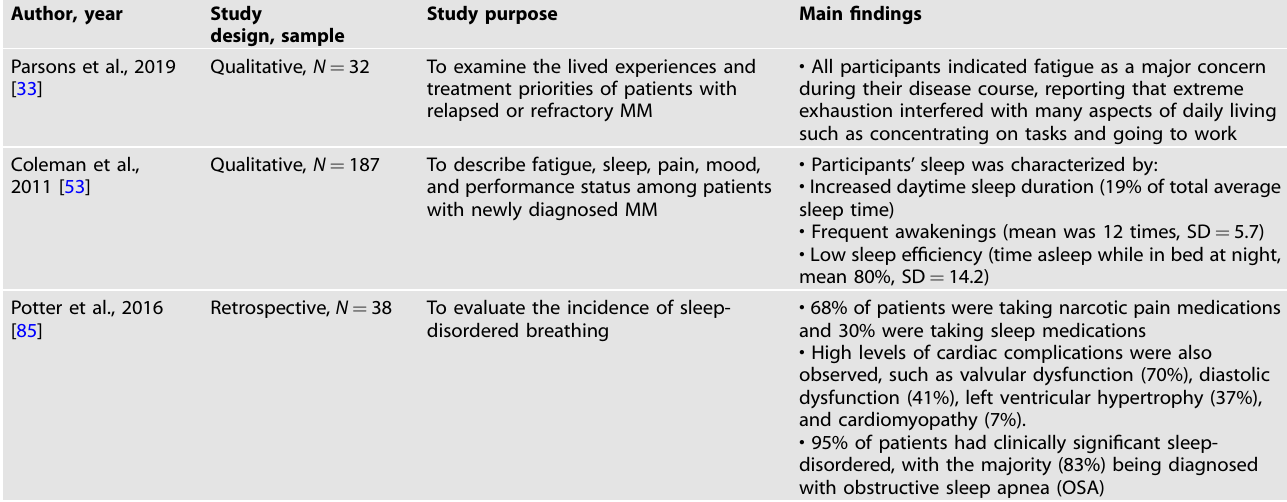
Table 2. Sleep in MM